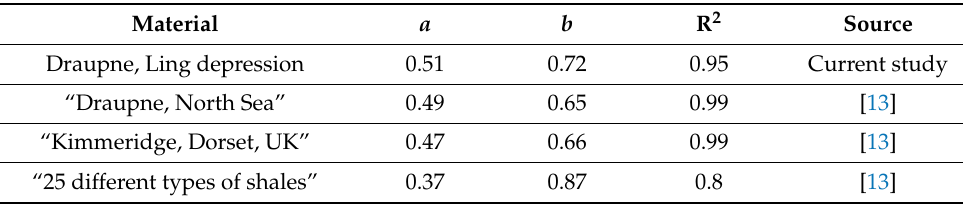
Table 5. Power regression fit parameters when normalized undrained shear strength is plotted versus OCR for Draupne tests in this study and for Draupne, Kimmeridge and a compilation of 24 different types of shale in Gutierrez et al. [13]. The referenced Draupne and Kimmeridge were not given with sample depths, but the max burial depth and apparent pre-consolidation stress of Kimmeridge were 1.7 km and 22 MPa,